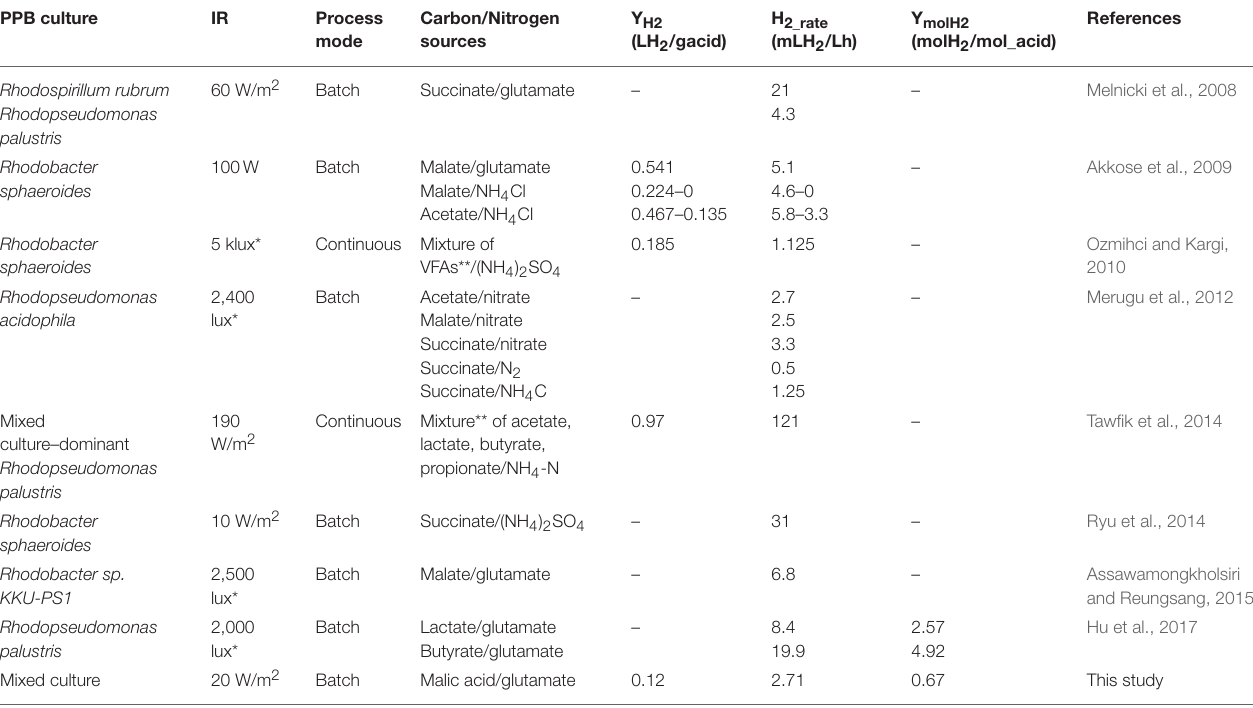
TABLE 3 | Comparison of hydrogen production rates by different cultures and systems with the one studied in the present work. PPB culture